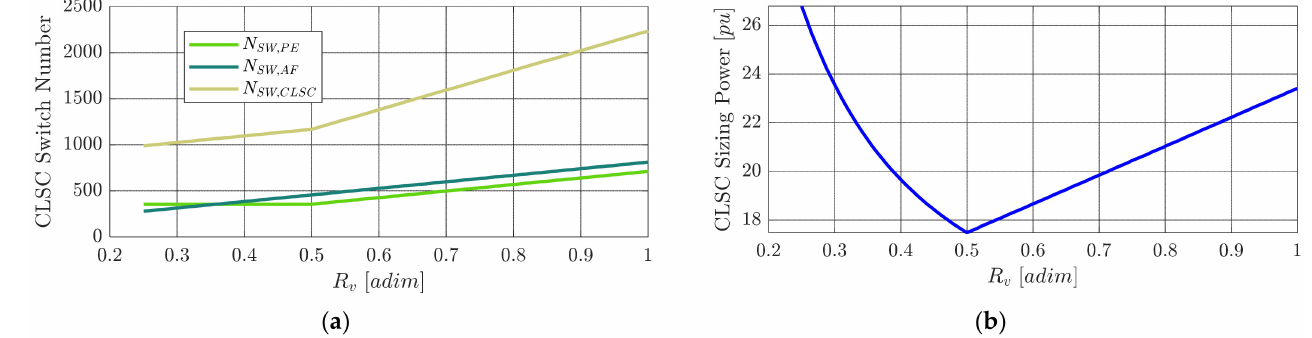
Figure 17. Open-delta CLSC switch number ( a ), and total switch sizing power ( b ). The SM capacitance and the converter’s stored energy are shown in Figure 18.